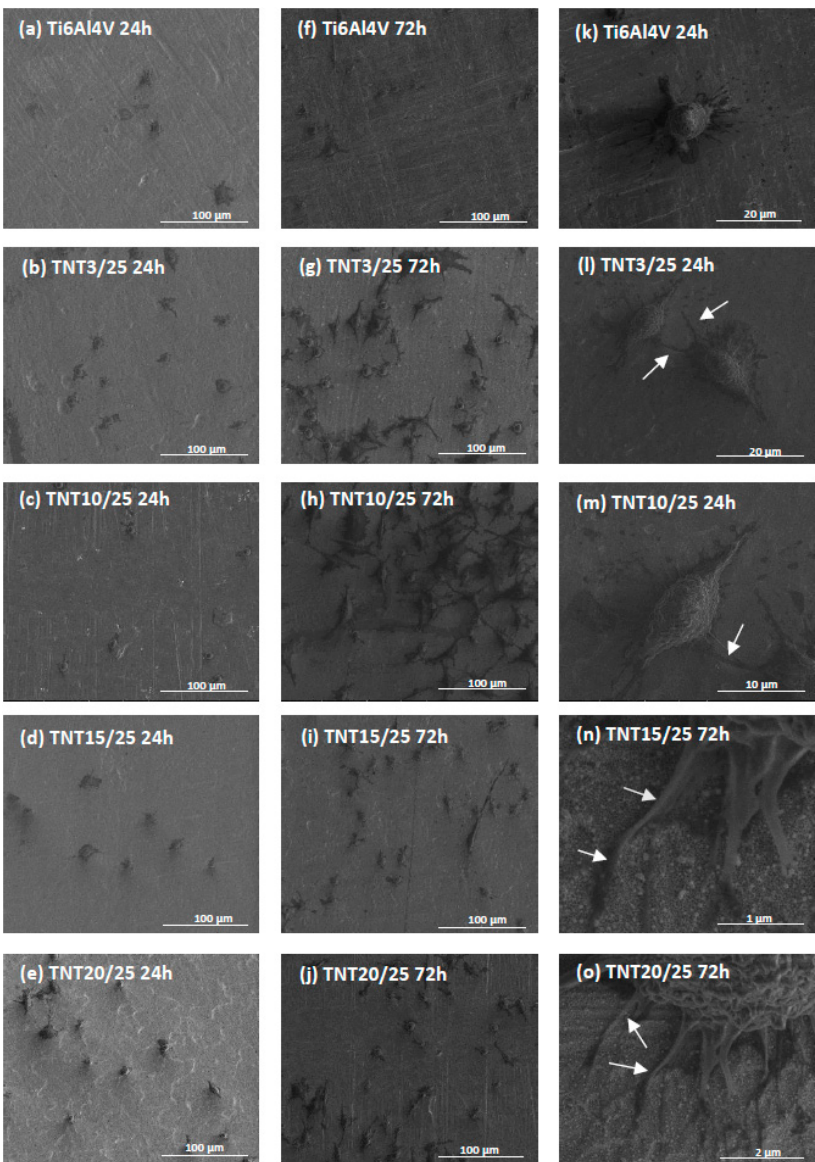
Figure 6. Scanning electron microscopy images showing the adhesion (after 24 h) and proliferation (after 72 h) of L929 murine fibroblasts on the surface of Ti6Al4V alloy and TNT/Ag coatings produces in PEALD process with 25 cycles (TNT3/25, TNT10/25, TNT15/25, TNT20/25) observed after 24 h ( a – e ) and 72 h ( f – j ) of incubation time, respectively. Figure ( k ) presents rounded shape of the cells incubated with Ti6Al4V reference sample for 24 h in comparison to the more elongated shape of the fibroblasts incubated with TNT3/25 ( l ) and TNT10/25 ( m ) for the same time period. Arrows in the figure indicate the filopodia spread between cells ( l – m ) or penetrating deep into the nanolayers ( n – o ).